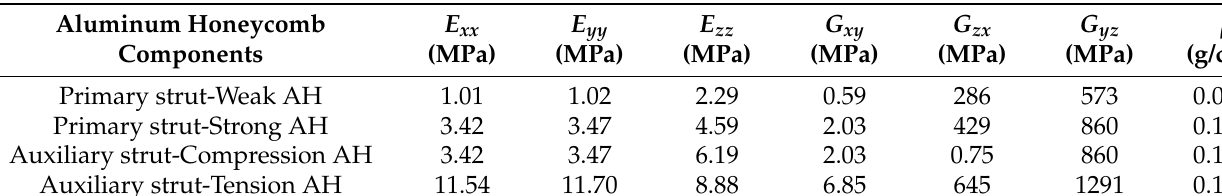
Figure 7. Diagram of aluminum honeycomb and the coordinate system. Table 4. Parameters of aluminum honeycomb materials.